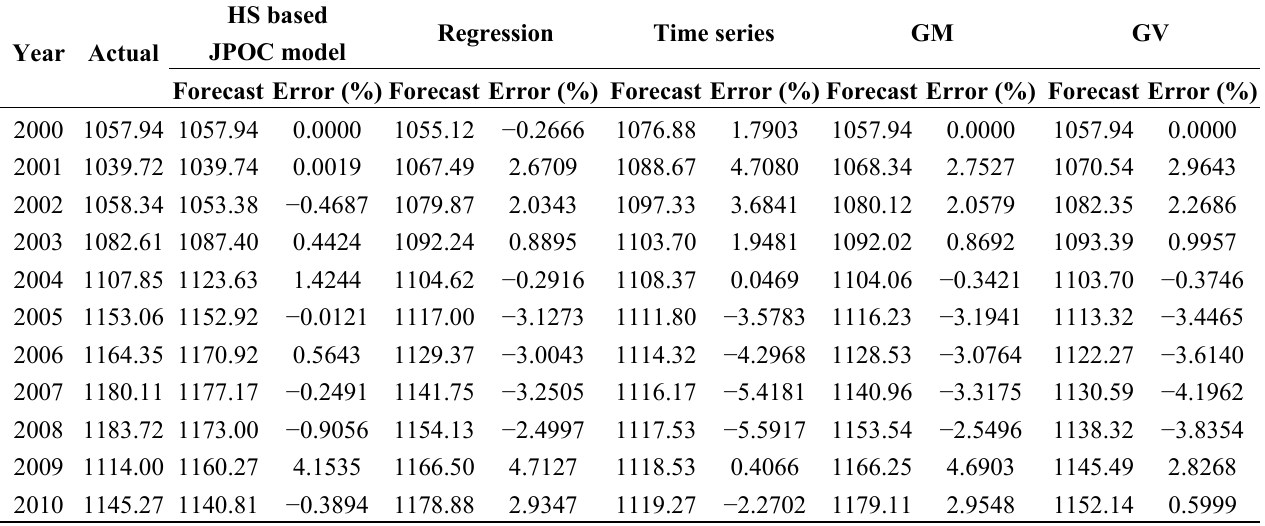
Table 4. Forecasting results of HS based JPOC model and other four single models for Japan (TWh).